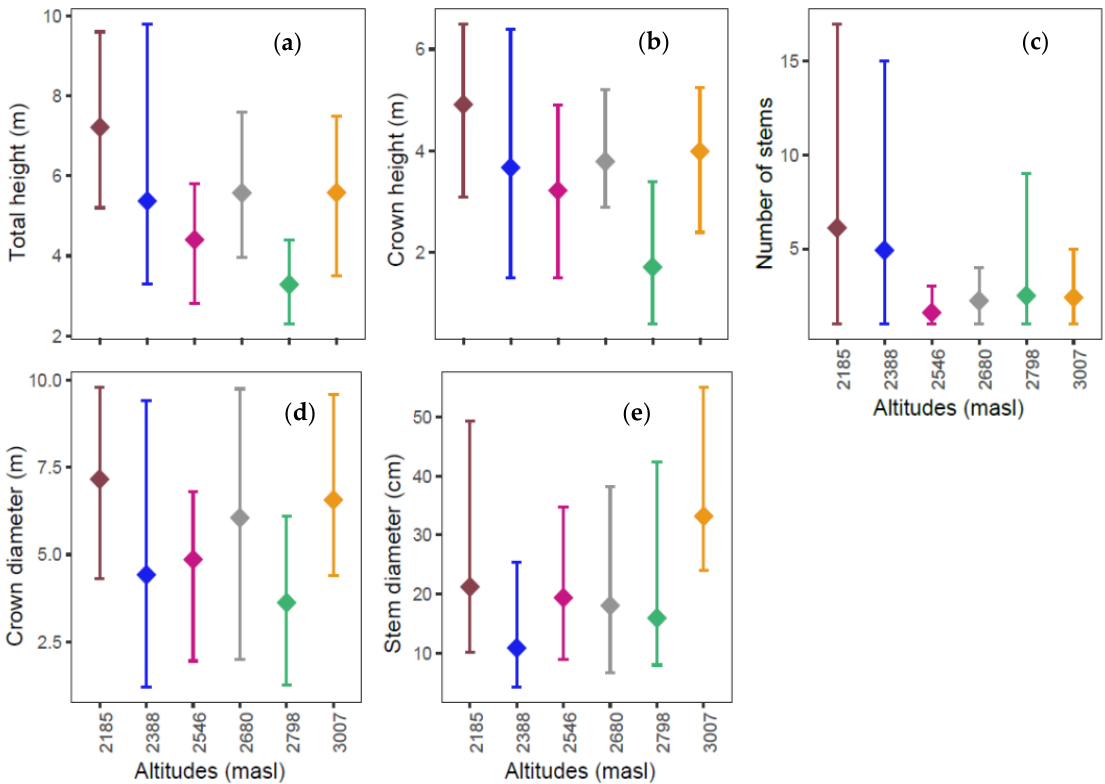
Figure 4. Dendrometry of the Tara tree in an agroforestry environment; tree height ( a ), crown height ( b ), number of stems ( c ), crown diameter ( d ), stem diameter ( e ). The mean was followed by the bootstrap method’s non-parametric confidence interval (CI: 95%).